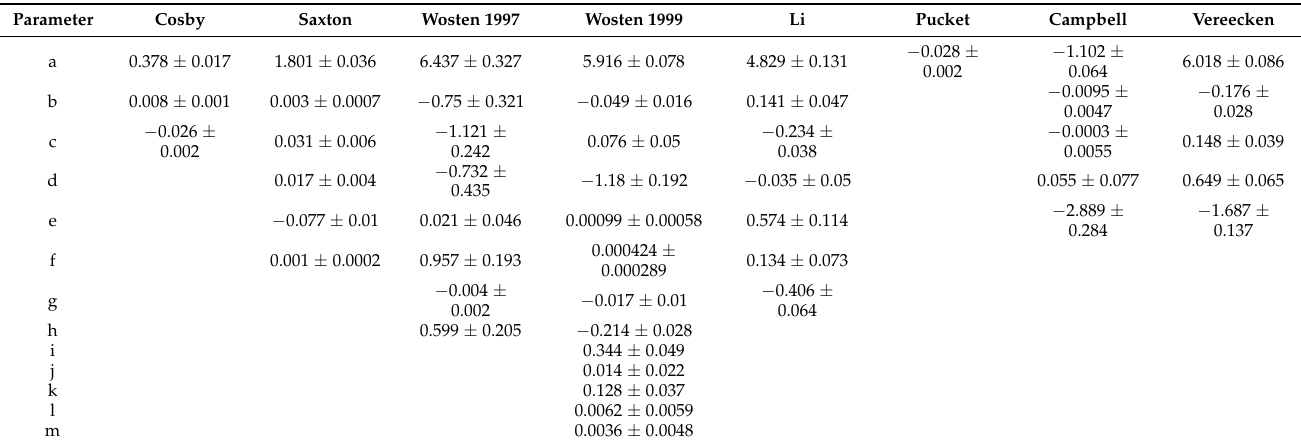
Table 4. Results of parameter correction by the least-square